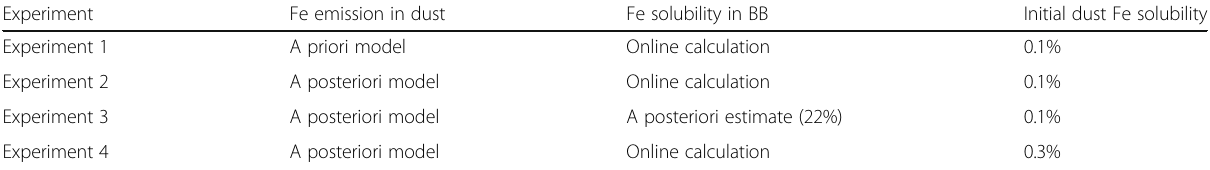
Table 1 Summary of sensitivity simulations performed for Fe emission for Australian mineral dust, Fe solubility for BB aerosols, and Fe solubility for mineral dust